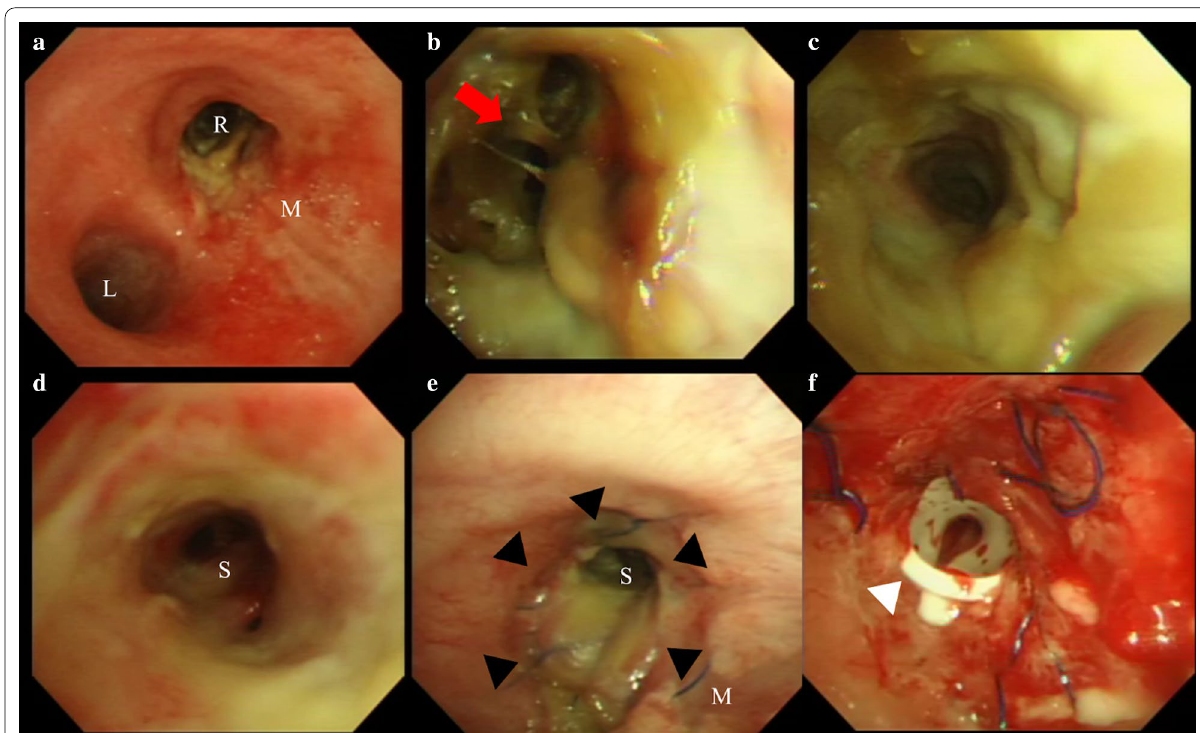
Fig. 3 a–d Preoperative bronchoscopy after debridement and e , f postoperative bronchoscopy a The trachea, carina, and right (R) and left (L) main bronchus. The tracheal mucosa (M) is inflamed but maintained. b The right main bronchus and the secondary carina (red arrow). The bronchial wall is severely necrotic. c The bronchus intermedius. The bronchial wall appears necrotic. d The lumen of the basal segmental bronchus (S). The mucosa is inflamed but not necrotic. e The anastomosis of the bronchus immediately after the operation (black arrowhead). f A silicone stent was placed into the stenosis site (white